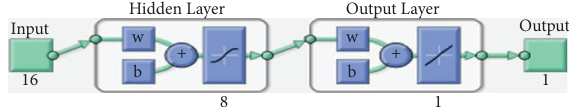
Figure 3: Network structure diagram.